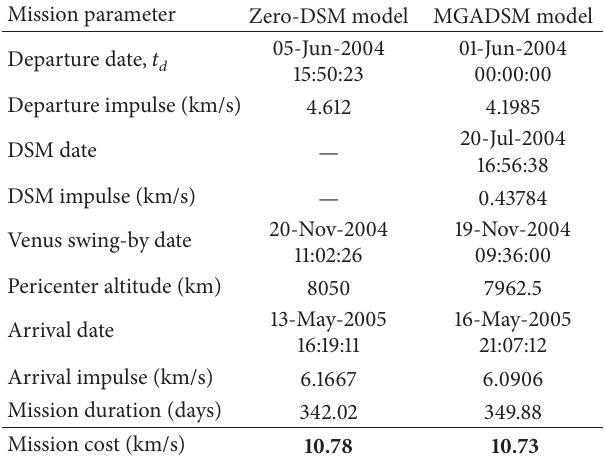
Table 5:Boththezero-DSMand MGADSM solutionsfortheEarth- Mars mission.